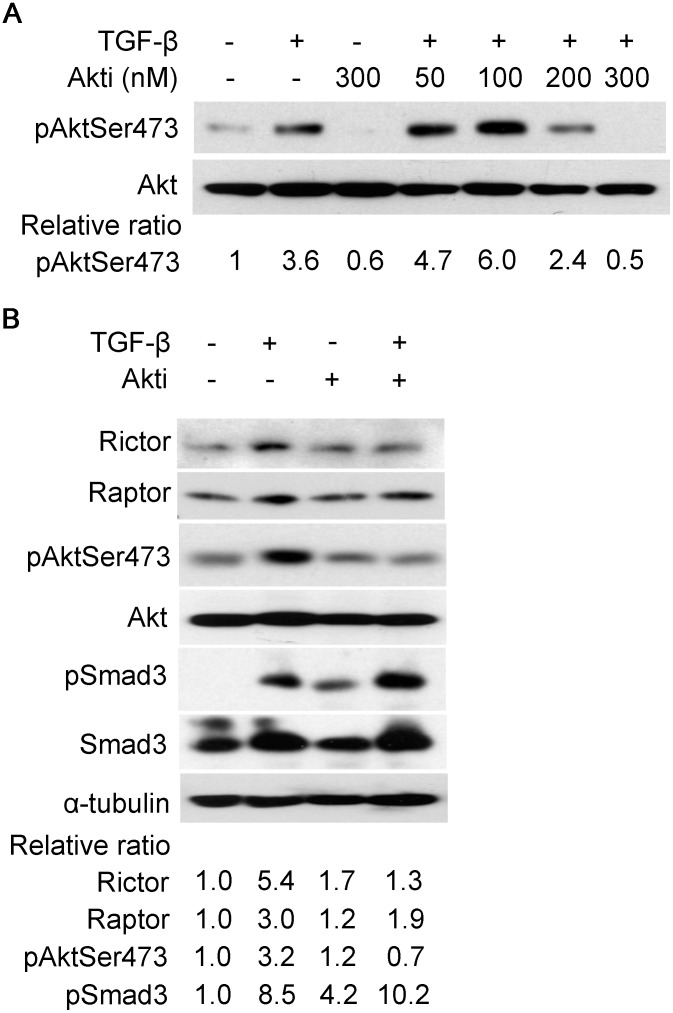
Akt inhibition suppresses induction of Rictor by TGF-β.Serum-starved IPF fibroblasts were pre-treated with Akti (Akt inhibitor VIII/124018) for 30 minutes or left untreated prior to TGF-β (5 ng/ml) treatment for two hours. In (A) cells were pre-treated with Akti at indicated concentration as shown, then followed by TGF-β treatment; (B) cells were pre-treated with Akti at 300 nM prior to TGF-β treatment or left untreated. Total cell lysates were prepared and equal amounts of protein were analyzed by Western blot analysis with specific antibodies as indicated. α-tubulin was used as a loading control.